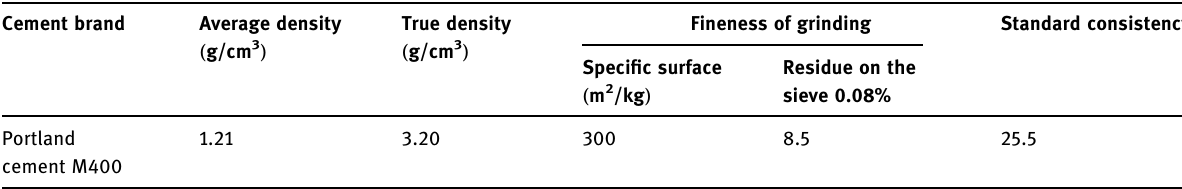
Table 1: Physical properties of Portland cement Cement brand